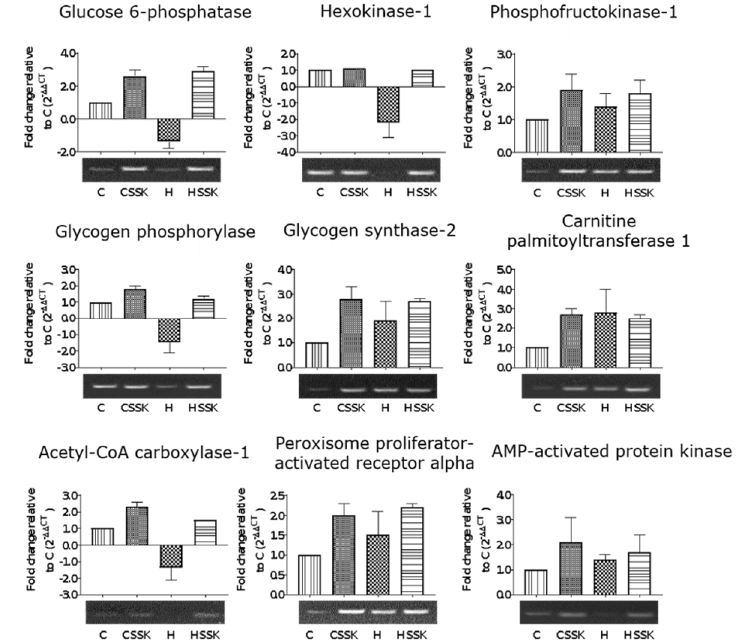
Figure 4. Saskatoon berry supplementation on gene expression of enzymes and transcription factors involved in liver glucose and lipid metabolism. The fold change relative to C was derived from technical duplicates of liver cDNA from three rats per treatment group. Error bars are presented as standard deviations. Changes in gene expression were considered significant if the P value was <0.05.